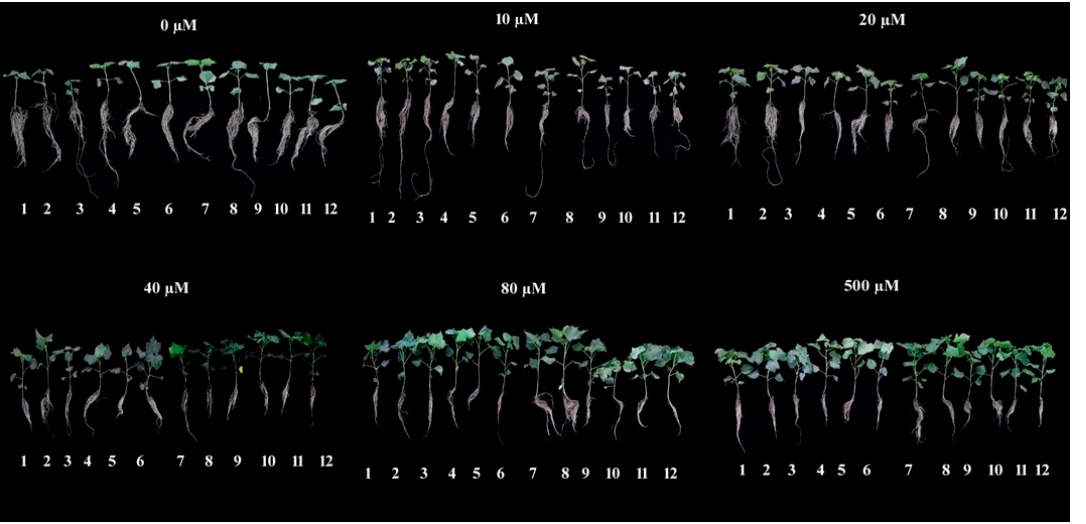
Figure 1. Representative examples of genotype-specific plant phenotypes of 12 cotton genotypes grown under various P concentrations (0, 10, 20, 40, 80, and 500 µ M). Each number from 1 to 12 represents genotypes TM-1, Yumian-21, CCRI-64, CCRI-27, Xinluzhong-17, Xinluzao-35, Xinluzao-48, Xinluzao-49, Xinluzhong-12, Xinluzhong-15, Xinluzao-20, and CCRI-12, Table 1. Shoot length (SL, cm), root dry weight (RDW, g), shoot dry weight (SDW, g), total plant dry weight (TDW, g), number of leaves (NOL), and leaf area (LA, cm 2 ) of 12 cotton genotypes grown at different P concentrations in hydroponic culture.